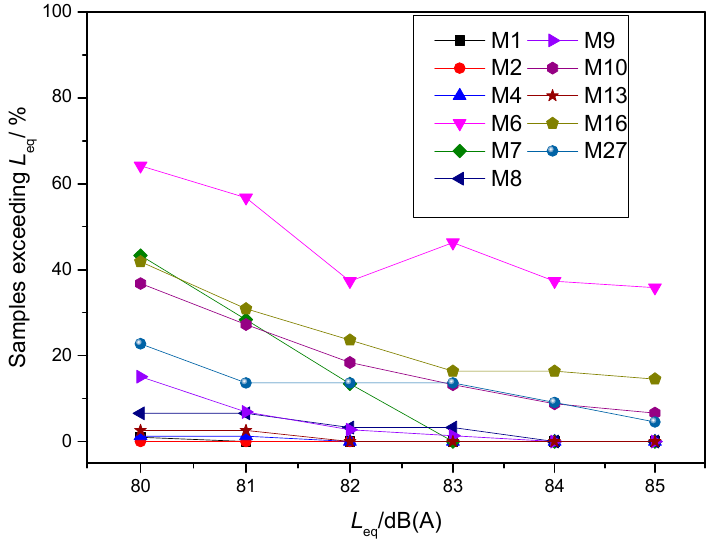
Figure 15. Proportions of samples exceeding different equivalent SPLs.